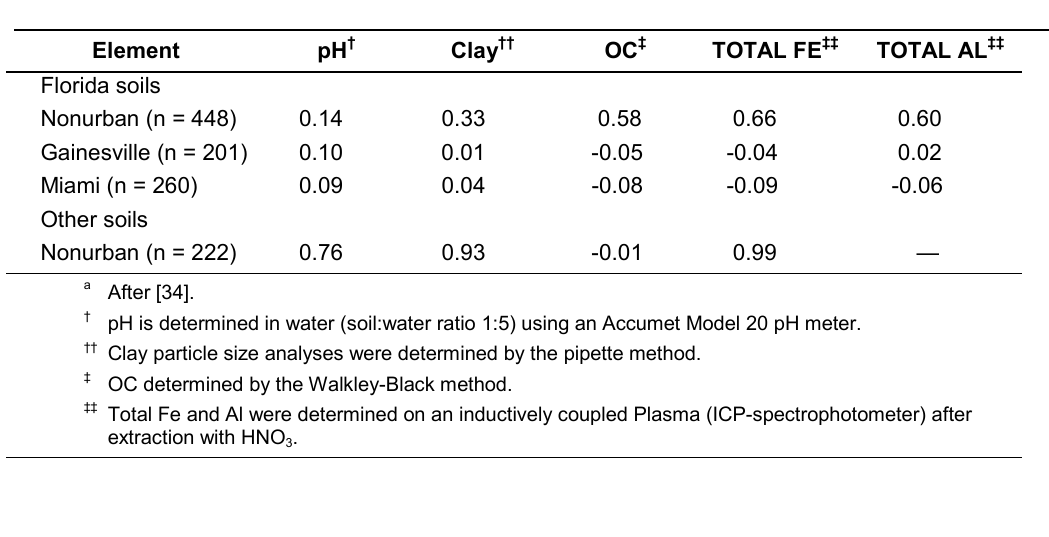
Correlation Coefficients of Arsenic Concentrations with Soil Properties in Urban and Nonurban Areas